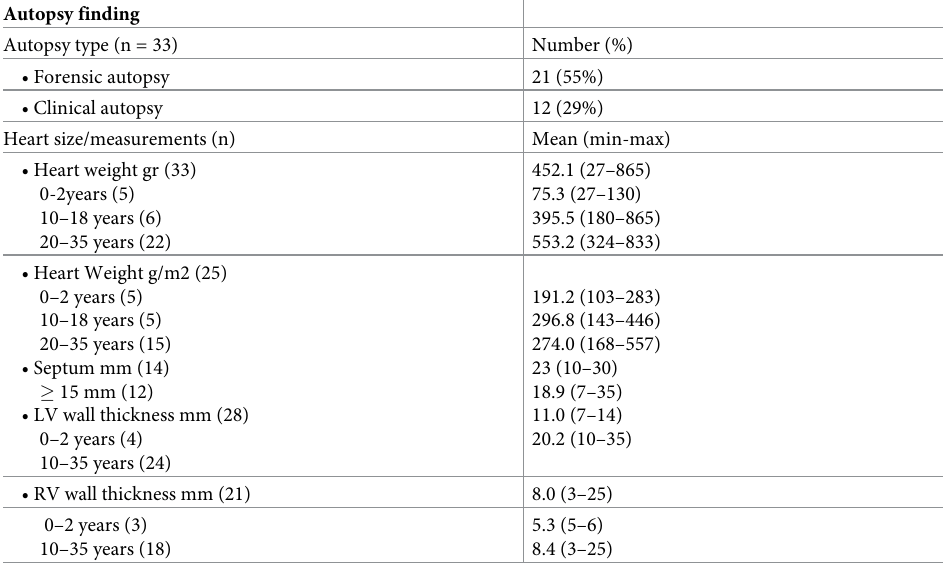
Table 2. Autopsy findings among 33 SCD victims due to